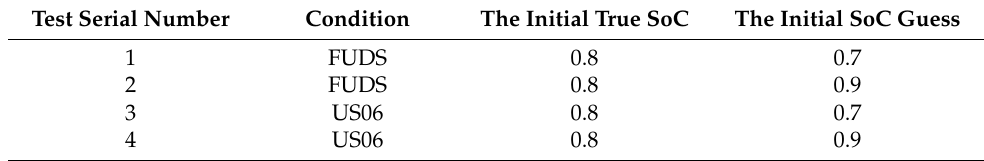
Table 5. Battery charge and discharge tests.